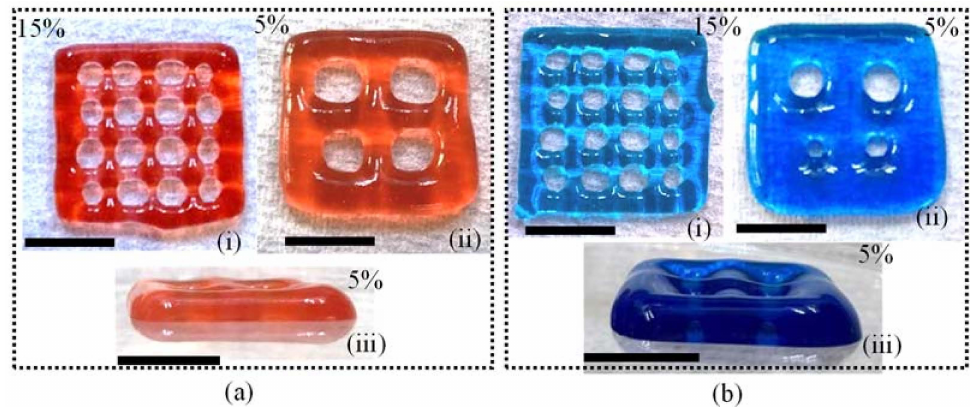
Figure 15. Scaffolds fabricated with ( a ) A 3 C 3 T 0.01 and (i) 15% porosity, (ii) 5% porosity, (iii) lateral view of the scaffold having 5% porosity; ( b ) A 3 C 3 T 1 and (i) 15% porosity, (ii) 5% porosity, (iii) lateral view of the scaffold having 5% porosity. Scale bar = 10 mm.